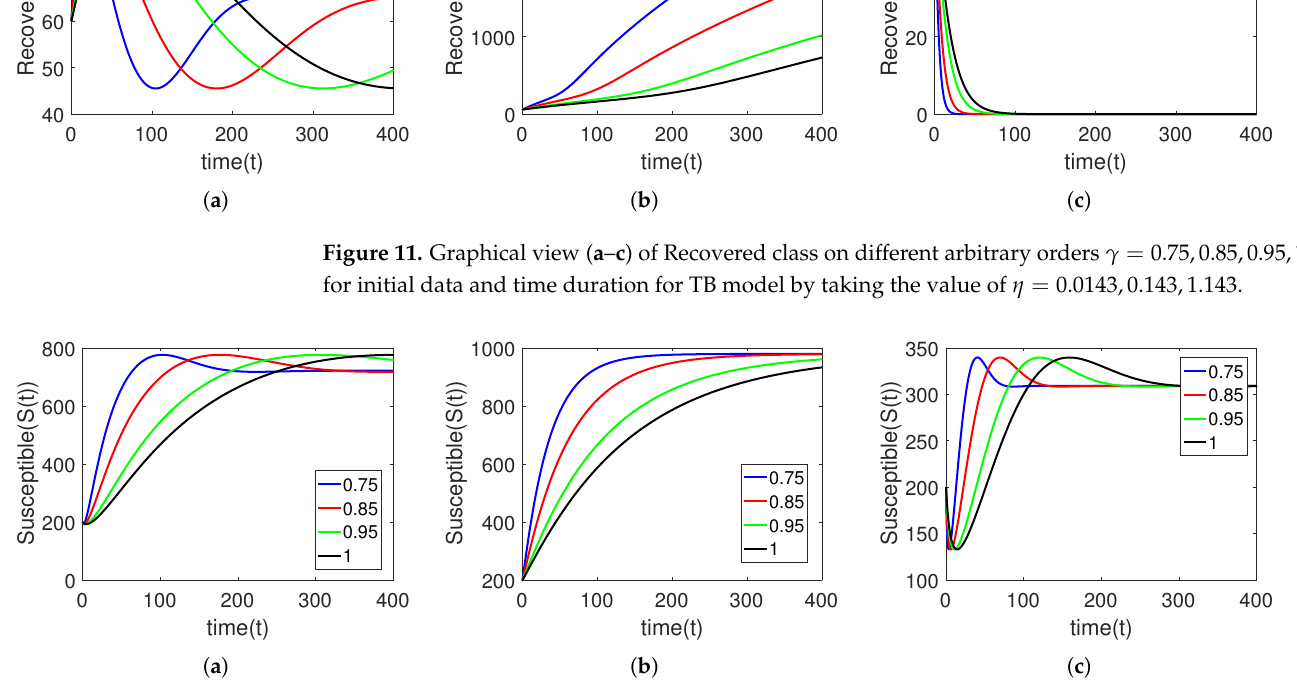
Figure 12. Graphical view ( a – c ) of Susceptible class on different arbitrary orders γ = 0.75,0.85,0.95,1 for initial data and time duration for TB model by taking the value of β =